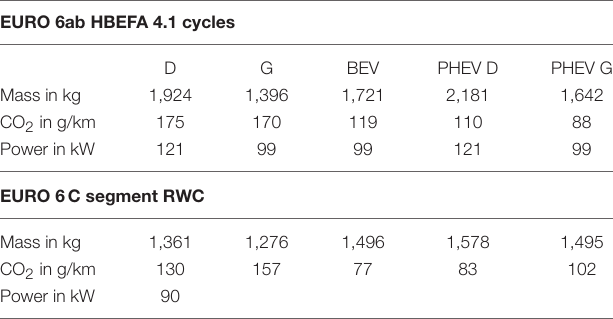
TABLE 12 | Overview of vehicle data (Matzer et al.,